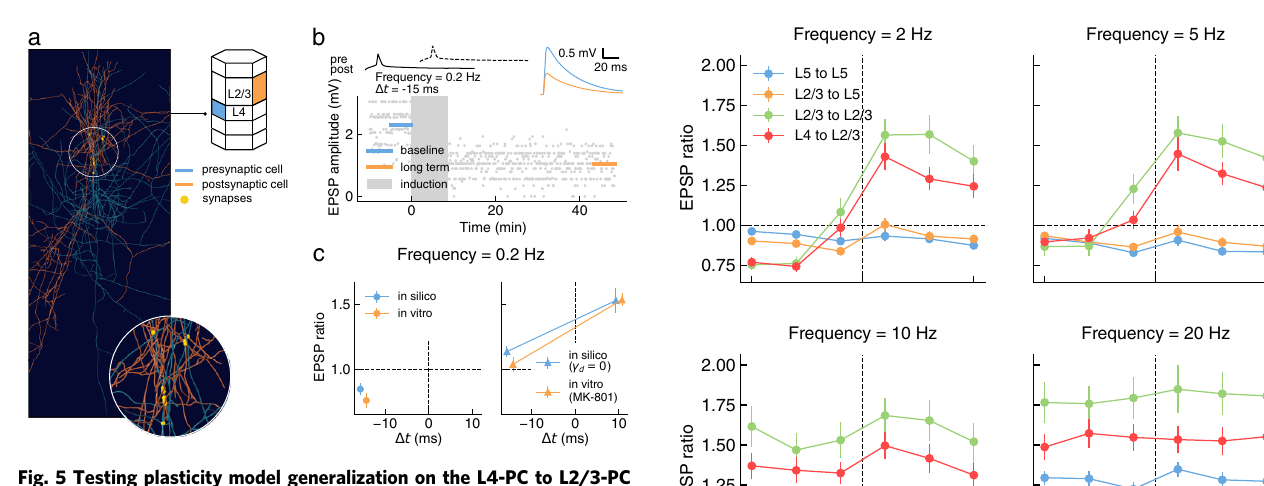
Fig. 5 Testing plasticity model generalization on the L4-PC to L2/3-PC connection type. a 3-D rendering of a representative pair of connected L4- PC to L2/3-PC in the in silico model. Inset shows a magni fi ed view of the synapses mediating the connection (yellow spheres). b Evolution over time of simulated EPSP amplitude during a typical plasticity induction protocol (top left; one pairing shown out of 100). Mean EPSP amplitudes (top right) are shown before (baseline; blue) and after (long term; orange) the induction protocol. c Comparison of EPSP ratios in silico and in vitro for positive and negative timings and with presynaptic NMDAR blocker MK801. Experimental data and simulations without MK801 on the left panel, with MK801 (in vitro) and γ d = 0 (in silico) on the right panel. Welch's unequal variances two-sided t-test was n.s. for every protocol ( p-value from negative to positive stimulation timing: 0.268, 0.209 MK801, 0.959 MK801; n = 100). Experimental data (in vitro) from Rodríguez- Moreno and Paulsen 42 . Population data reported as mean ± SEM. For the full distribution of in silico experiment outcomes see Supplementary Fig. A.14 and Supplementary Fig. A.15.